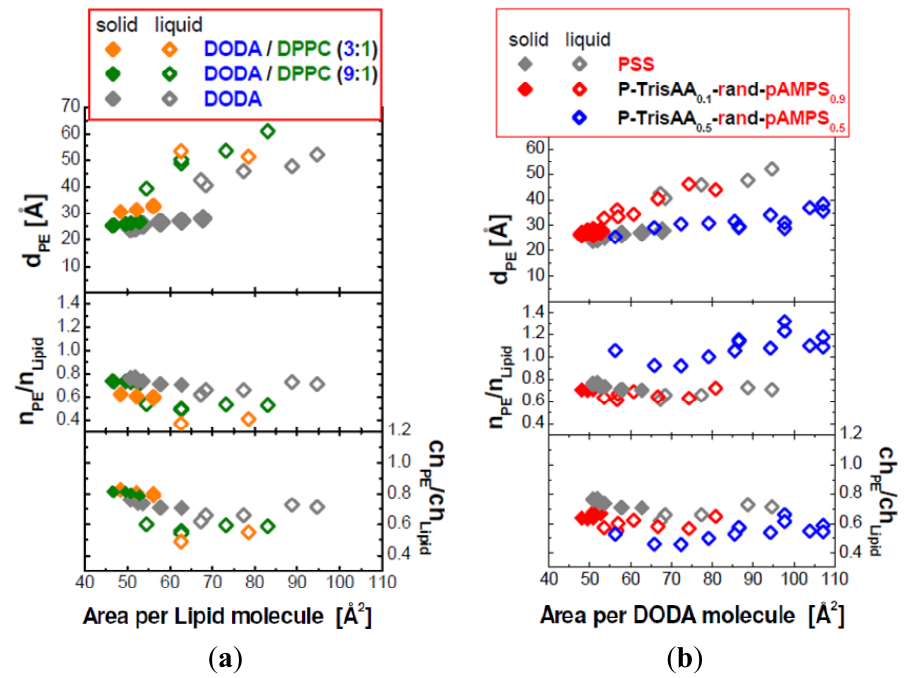
on the molecular area A PE –rand–AMPS adsorbed to DODA. x 1 − x / n . Bottom row: PE Lipid /ch PE Lipid